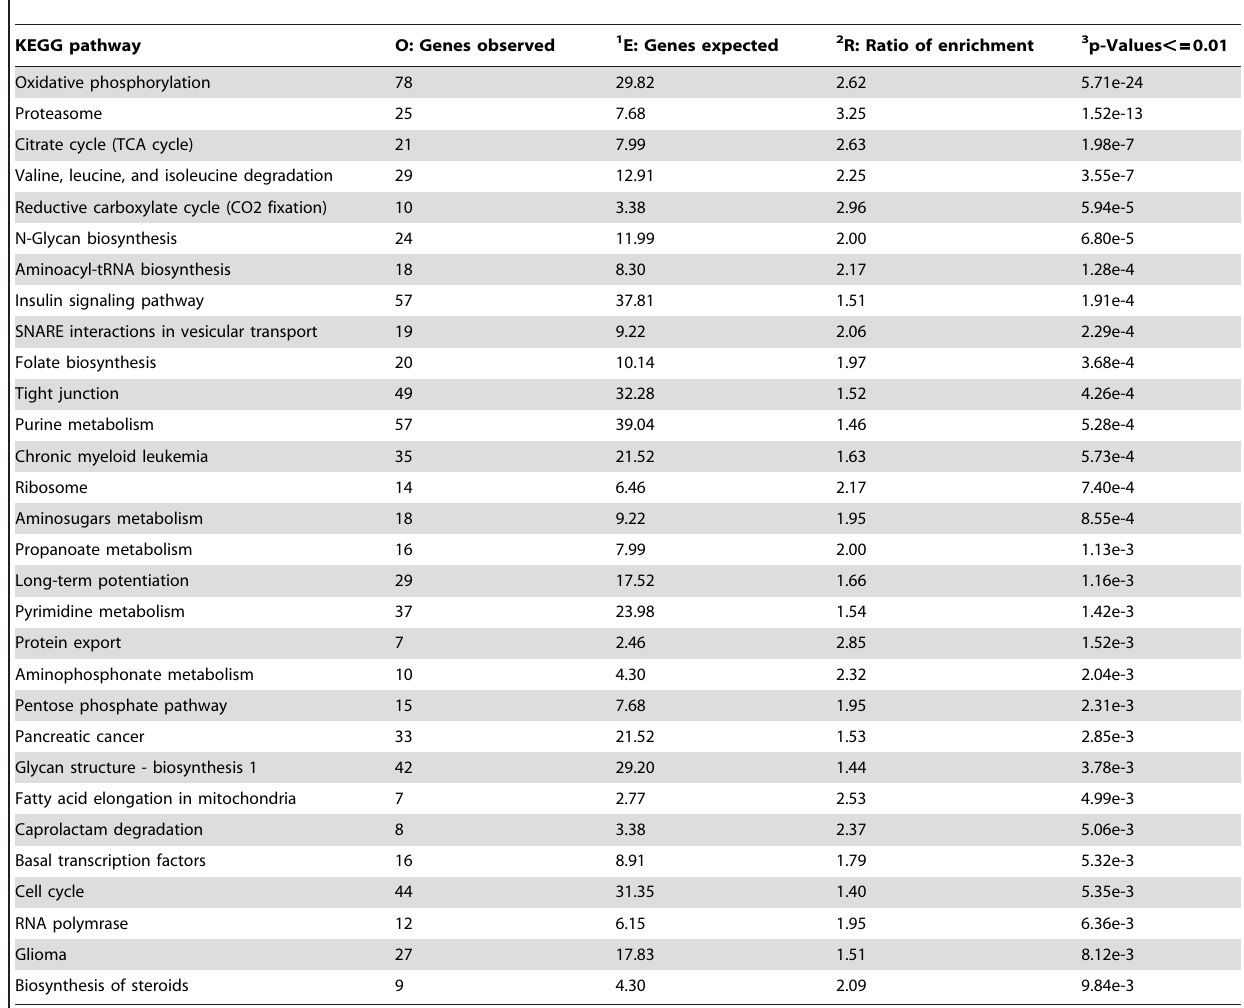
Table 4. Significantly enriched KEGG pathways for predominantly-on genes ( p , =0.01).